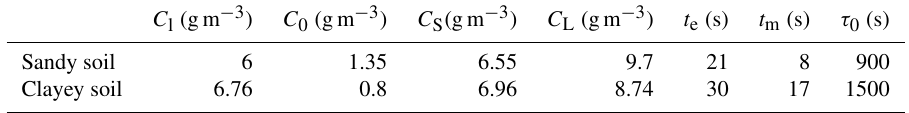
Table 1. Sandy soil and clayey soil inertial evaporation